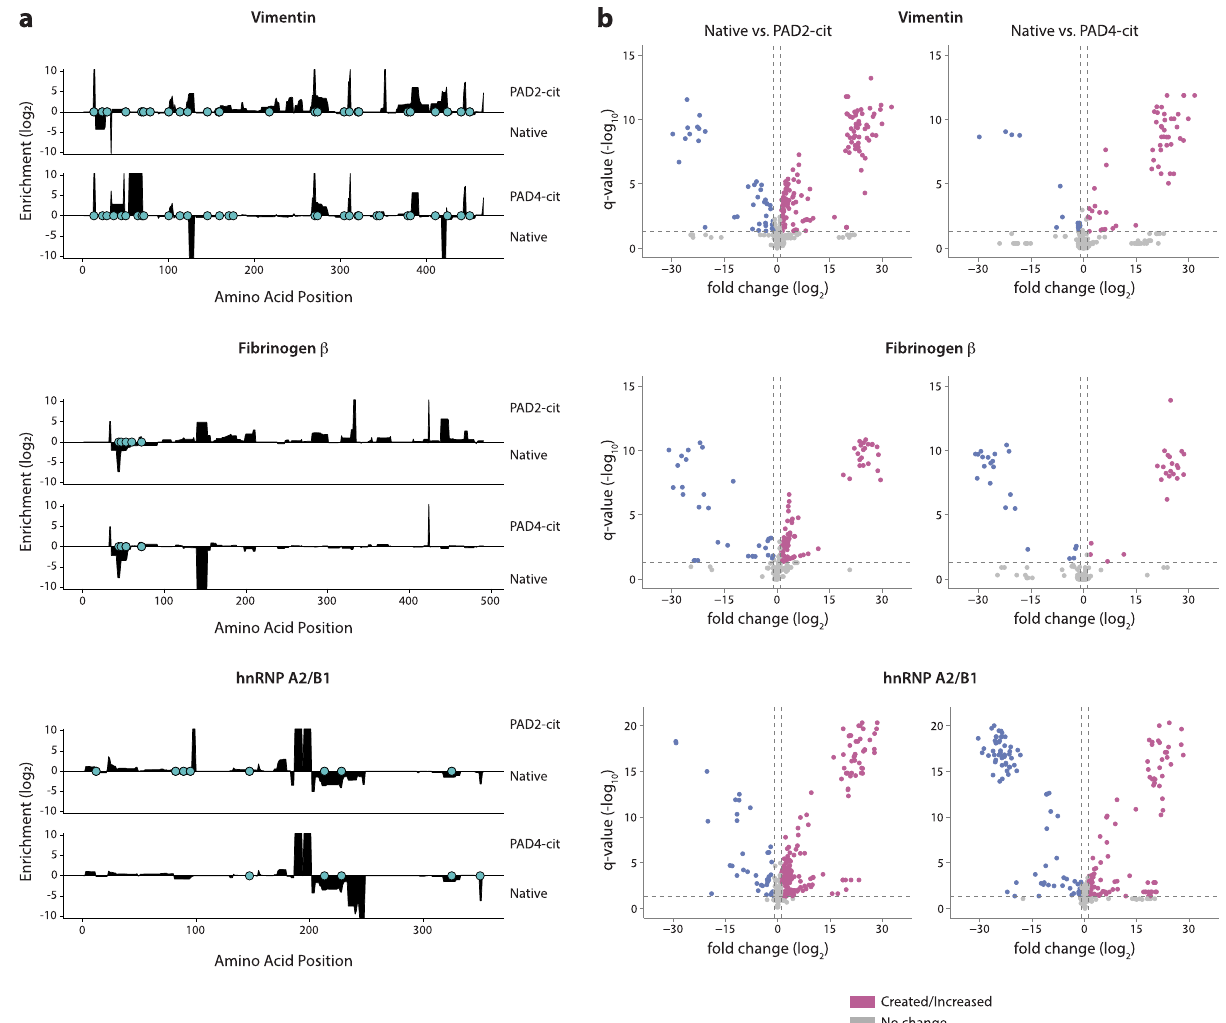
Fig. 1 | Citrullination alters antigen processing, resulting in the simultaneous generation of cryptic peptides and the destruction of previously dominant peptides.a Log 2 enrichmentofpeptidesfromproteolyticmappingwithcathepsins BSHacrosstheprimaryaminoacidsequenceofeachprotein.Aminoacidpositions with positive values are enriched in the PAD2- or PAD4-citrullinated (cit) samples comparedtothenative(nat)samples,whilethosewithnegativevaluesarereduced by citrullination. Citrulline residues are denoted by the fi lledblue circles on x axes.